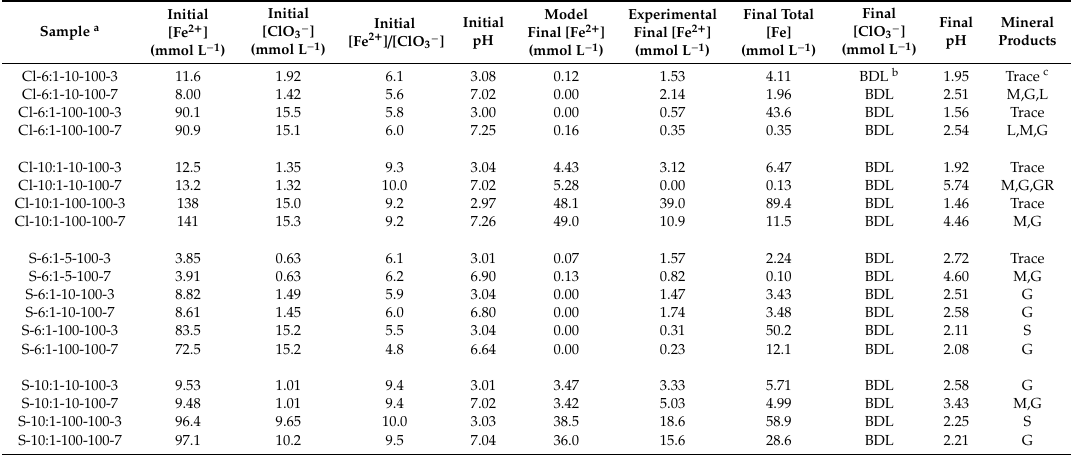
Table 2. Fluid composition of the mineral precipitation